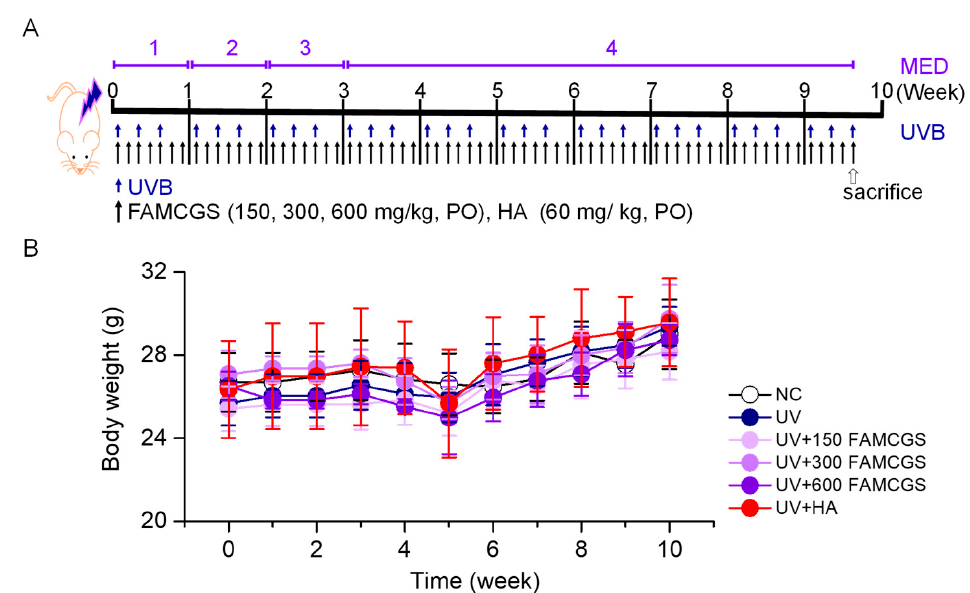
Figure 3. Establishment of the UV-irradiated skin aging model ( A ) A protocol for the UV-irradiated skin aging model. UVB exposure was performed for 10 weeks. FAMCGSs and HA were preadministered for 10 weeks by oral gavage. The blue and black arrows indicate exposure to UV and FAMCGSs or HA. ( B ) Changes in body weight measured during the 10 weeks of the experiment. NC, UV, FAMCGS, and HA represent normal control without UV irradiation, ultraviolet, fermented and aged mountain-cultivated ginseng sprouts, and hyaluronic acid, respectively.